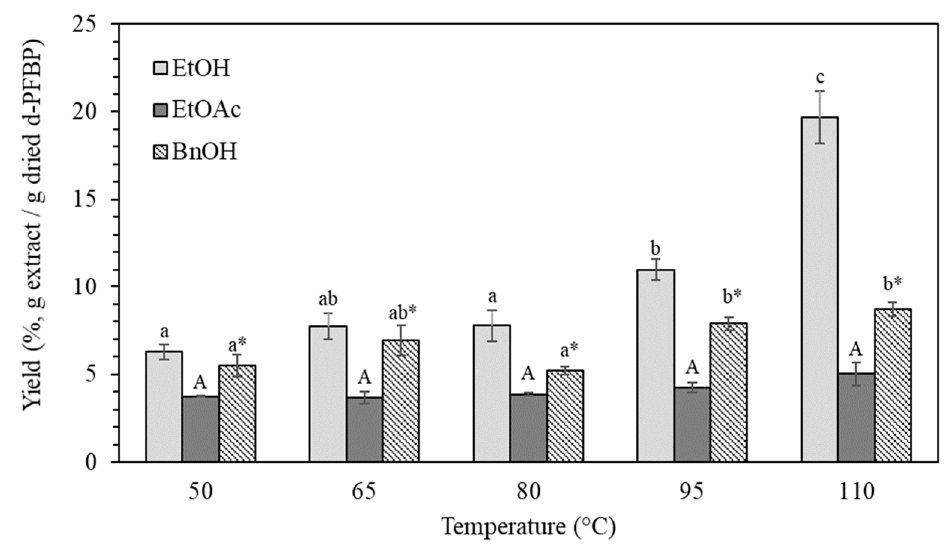
Figure 1. Yield of d-PFBP extract obtained by the single-cycle PLE using different solvents. Mean values that share the same lowercase without asterisk, uppercase without asterisk, or lowercase with asterisk did not show a significant difference for Ethanol (EtOH), Ethyl acetate (EtOAc), and Benzyl alcohol (BnOH), respectively, according to Tukey’s test ( α = 0.05). The highest yield was achieved with EtOH at 110 °C (19.67 ± 1.47 wt %), while the lowest was for EtOAc at 65 °C (3.65 ± 0.35 wt %), where no significant variation in tem- perature was observed. The yield for EtOH at 65 °C (7.72 ± 0.76 wt %) was lower than that found by Viganó et al. [7] in a continuous PLE process using EtOH at 70 °C (17.518 ± 2.964 wt %). However, the same authors used a considerably high volume of solvent (since it was a continuous process), and the search for alternative solvents and less-consuming solvent processes seemed to be required in order to concentrate phenolic compounds. In this work, a trend of increasing yield with temperature is observed for EtOH. Curiously, the other solvents did not show any difference in extraction yield with temperature vari- ation. It is important to point out that the extracts’ color intensified as the temperature was raised for all tested solvents (especially for EtOH) (Figure S3 in supplementary mate- rial). This could indicate the presence of products from sugar browning reactions at ele- vated temperatures, which could also have affected the yield. The conventional solid–liq- uid extraction achieved a yield of 7.538 ± 0.295 wt %, corroborating the results from Rotta et al. [6], who performed solid–liquid extraction in PFBP at 80 °C using EtOH:H 2 O (70:30, v/v ) as solvent and found a yield of 8%. The quantification of piceatannol was the starting point in outlining the following PLE extraction conditions. Table 2 presents piceatannol concentration in the extracts of d- PFBP, and the calibration curve of piceatannol (R 2 = 0.9989) is presented in Figure S4 in the supplementary material. Despite the HSPs predictive step suggesting BnOH as the solvent with lower Ra , results indicated EtOH as the best solvent to concentrate piceatan- nol in the d-PFBP extracts. For the single-cycle PLE conditions, an increase of temperature improved piceatannol and TPC concentration in the extracts (Table 2). Such observation is corroborated by Santana et al. [4], who confirmed that piceatannol concentration is di- rectly correlated with extraction temperature. More recently, Krambeck et al. [34] applied ultrasound-assisted extraction and reported values of around 10 μ g of piceatannol/mL extract of PFBP. Similar results were obtained in this work using EtOH at 110 °C (extracts were diluted to 1 mg/mL before injection). The highest piceatannol concentration in the extracts is attributed to the conventional solid–liquid extraction, as noted in Table 2. The PLE experimental results, together with those obtained by conventional solid–liquid ex- traction, suggest that piceatannol has better affinity to solvents with higher polarity or